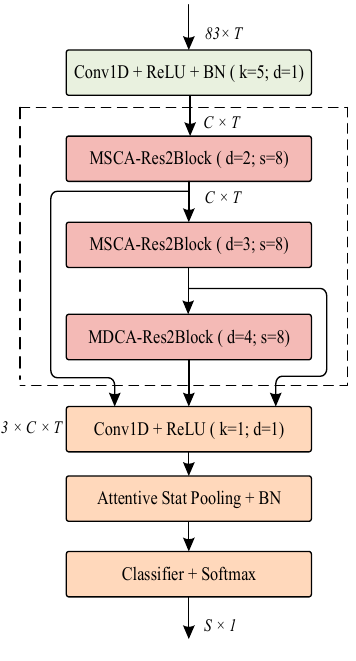
Figure 1. MSCA -TDNN. Figure 1.